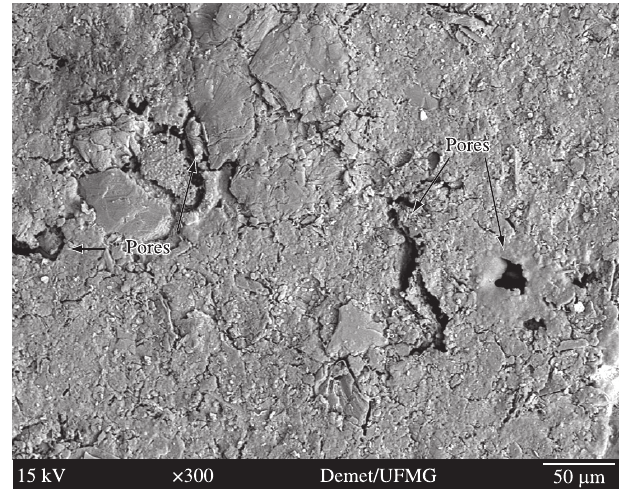
Figure 7. Composite C3, backscatter-mode scanning electron microscopy image.